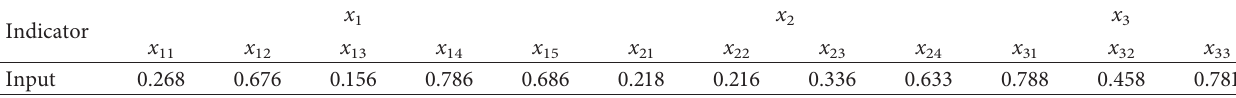
Table 4: Assessment inputs of building vulnerability indicators.